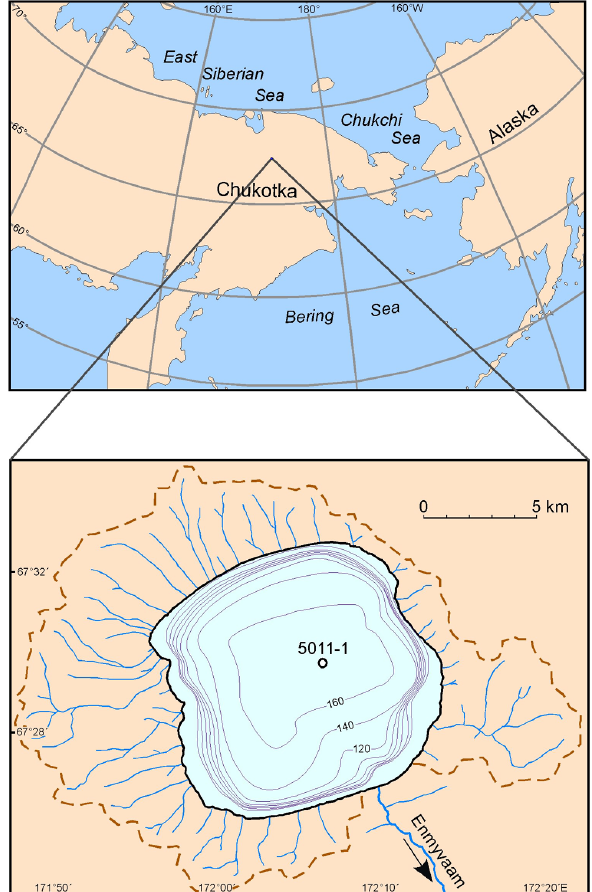
Fig. 1. Location map of Lake El’gygytgyn and its catchment. Bathymetry (20m contour interval) and stream network are mod- ified from Nolan and Brigham-Grette